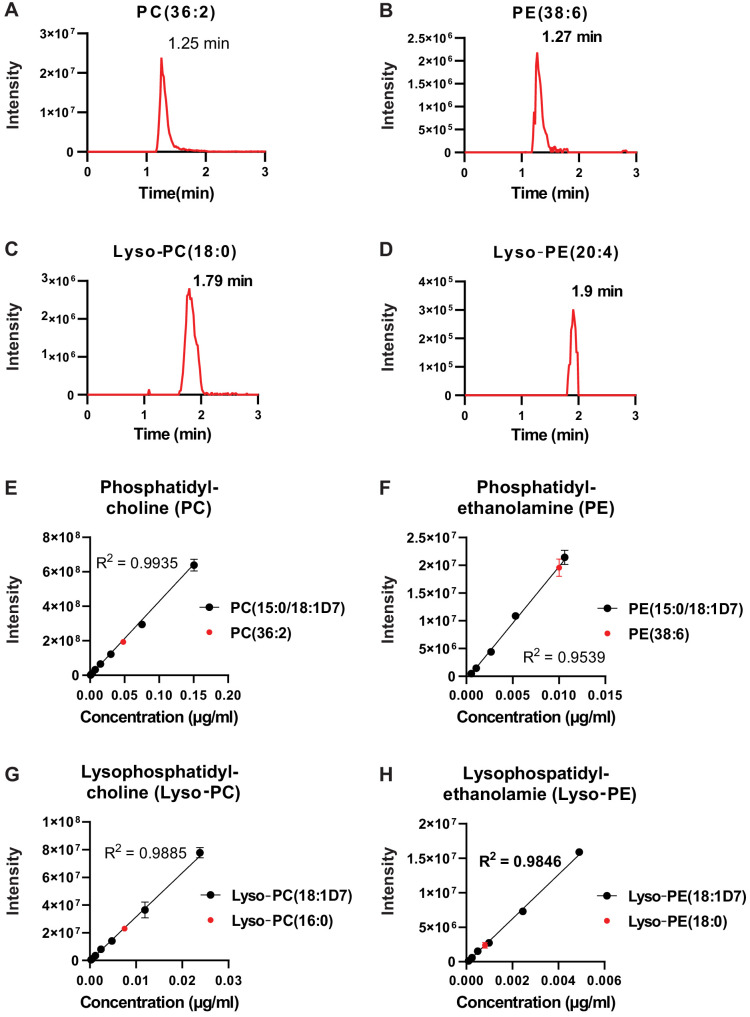
Chromatographic performance of lipids separated by HILIC.(A–D) Representative chromatograms for (A) phosphatidylcholine (PC [36:2]), (B) phosphatidylethanolamine (PE [38:6]), (C) lysophosphatidylcholine (Lyso-PC [18:0]), and (D) lysophosphatidylethanolamine (Lyso-PE [20:4]). (E–H) Standard curves of isotopically labeled lipids from four classes of lipids we detected (black) and the corresponding endogenous lipid (red) for (E) phosphatidylcholine, (F) phosphatidylethanolamine, (G) lysophosphatidylcholine, and (H) lysophosphatidylethanolamine (n = 3 replicates, data represent mean ± SD).
Figure 1—figure supplement 1—source data 1.Source data for Figure 1—figure supplement 1.